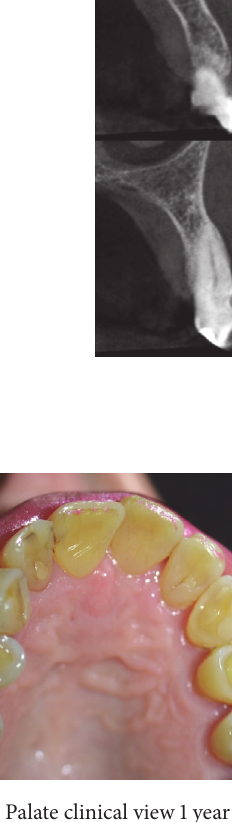
Figure 9: Palate clinical view 1 year after